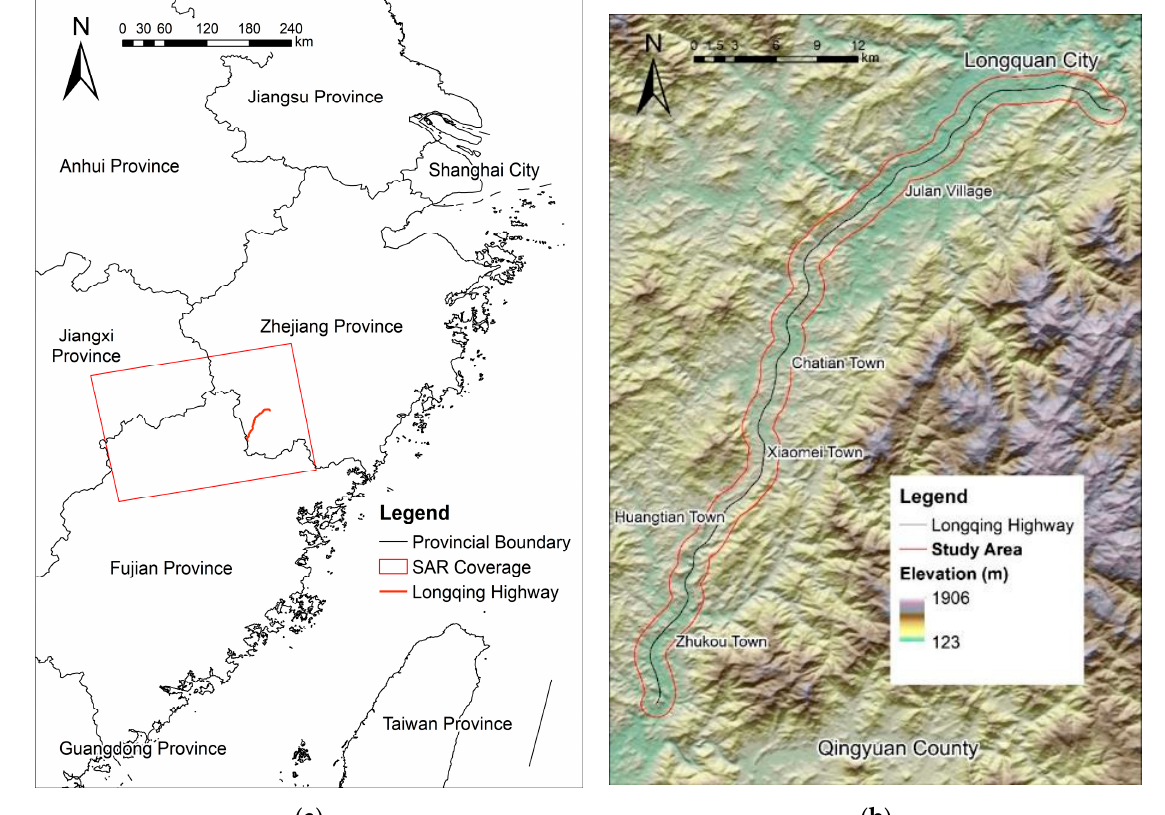
Figure 1. Study areas: ( a ) location of Longqing Highway and coverage of SAR image; ( b ) the STRM 1Sec 30 m digital elevation model of the study area.